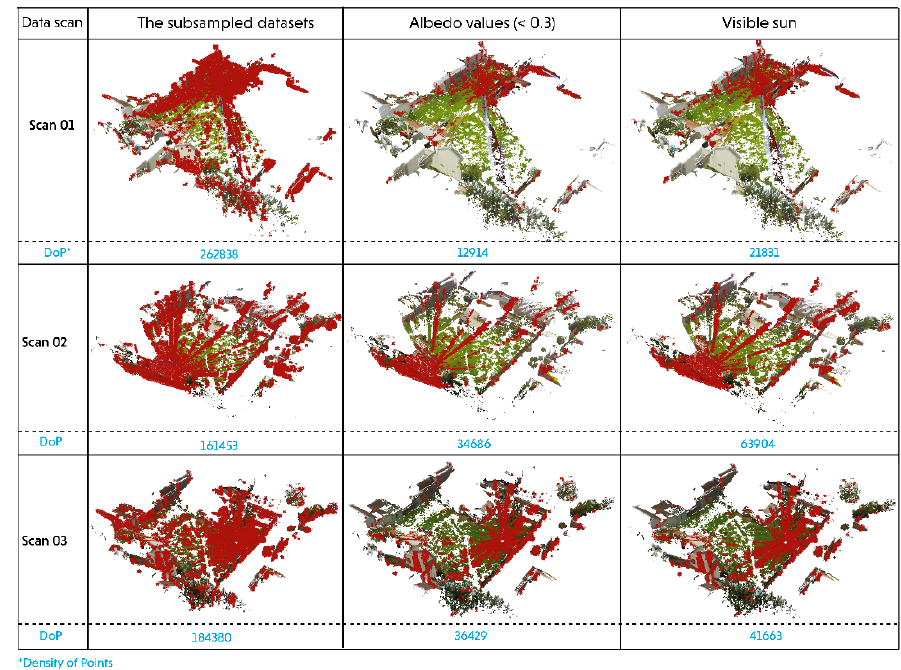
Figure 12. The resulting points after performing the selection criteria.